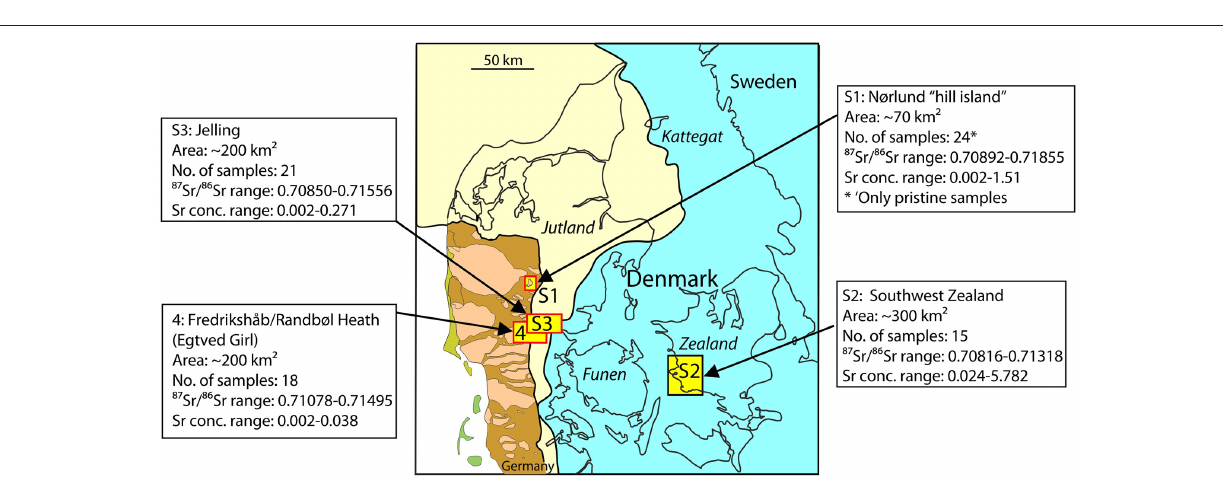
FIGURE 8 | Statistical summary of 87 Sr/ 86 Sr ratios and strontium concentration for each of the three study areas. Location of study areas is indicated on Quaternary geological map. Site 4 is based on data from Thomsen and Andreasen